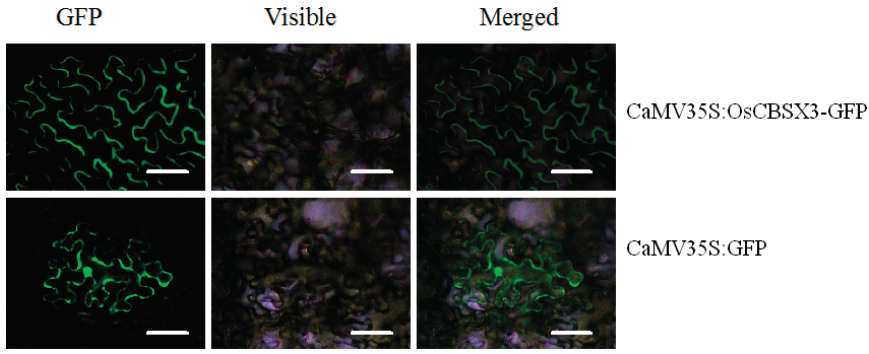
Figure 3. Subcellular localization of OsCBSX3 protein in N. benthamiana leaves. OsCBSX3-GFP (green fluorescent protein) exclusively localized in the plasma membrane of cell in N. benthamiana leaves. GFP alone localized throughout the whole cells. Cells were detected for GFP fluorescence by fluorescence microscopy 48 h after agroinfiltration. Scale bars =10